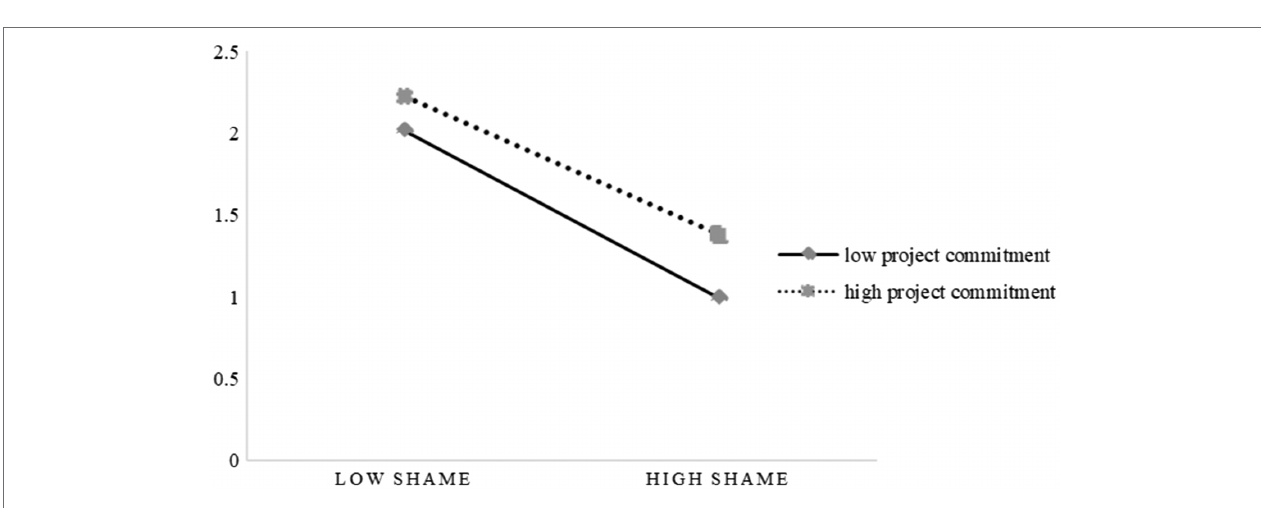
FIGURE 2 | The moderating role of project commitment.